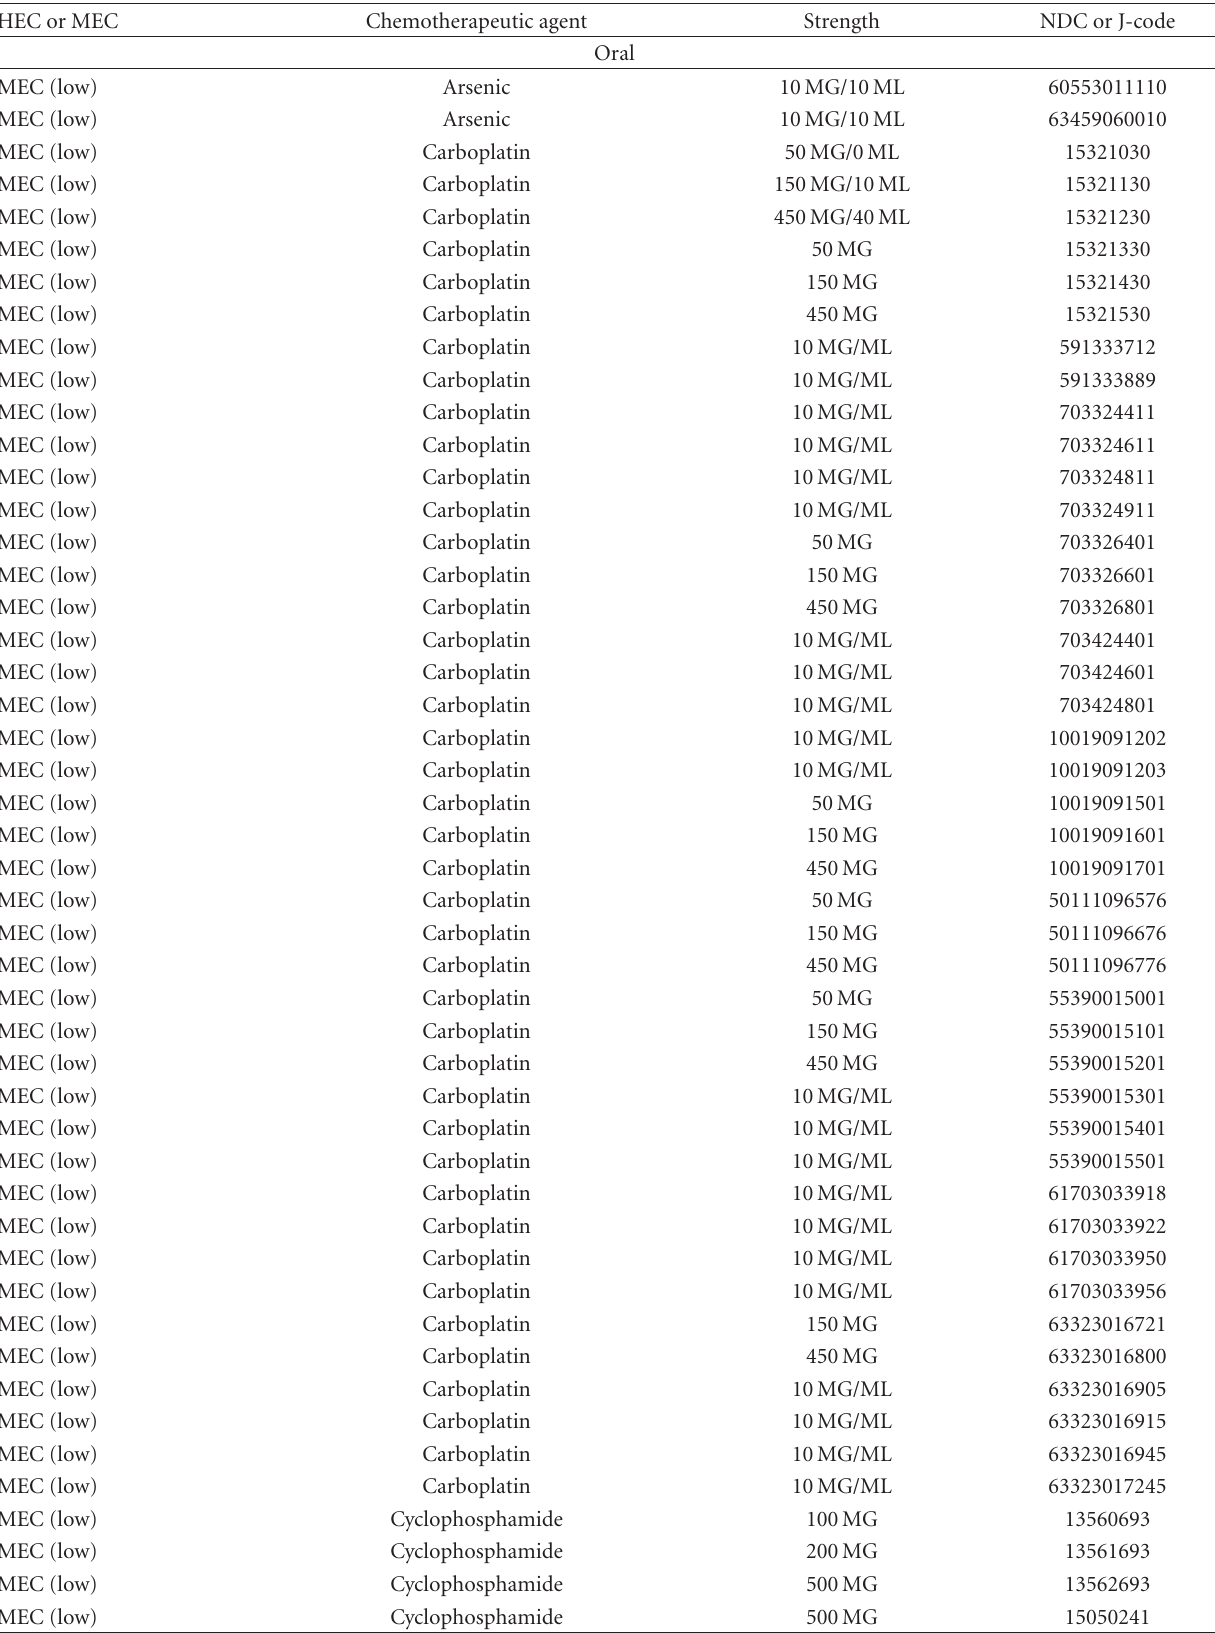
Table 5: Chemotherapeutic agents according to HEC or MEC